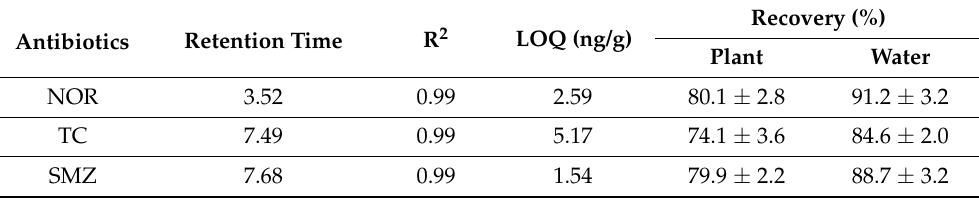
Table 2. Retention time, correlation coefficient, recovery, and limit of quantification (LOQ) of samples.